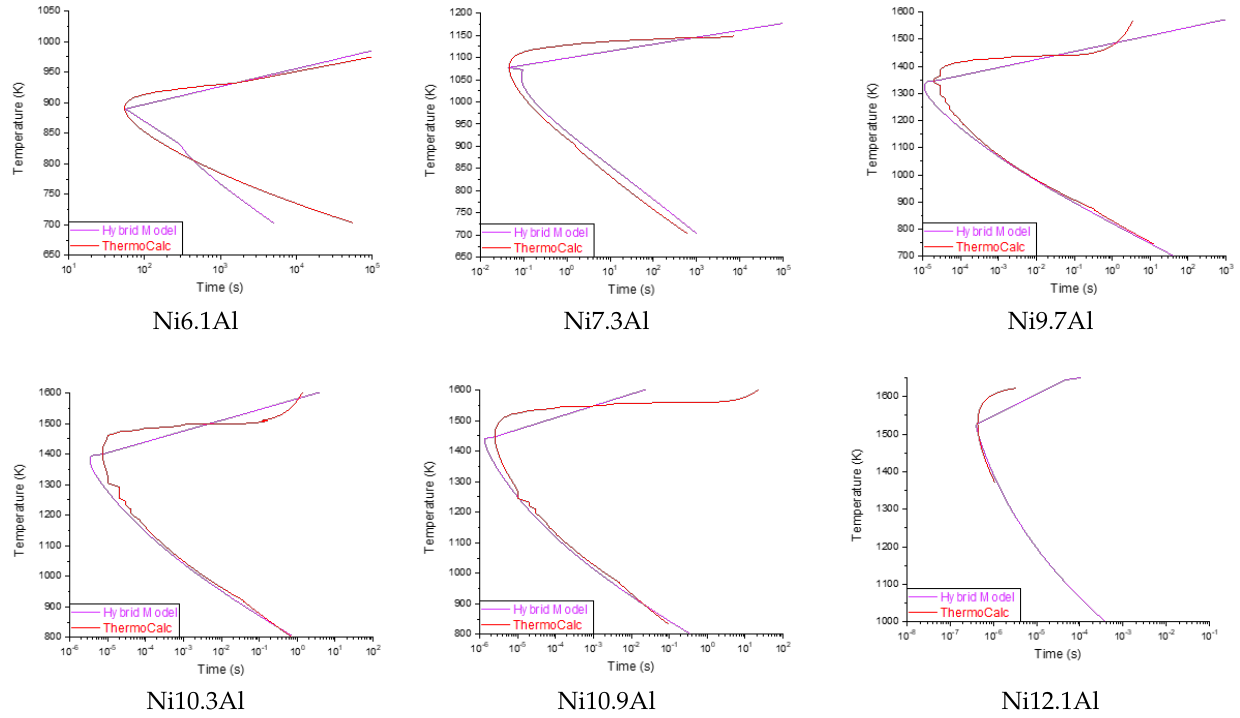
Figure 6. Prediction results for several chemical compositions of the proposed hybrid model against the Thermo-Calc™ . Table 7 shows the precision for each plot. As the chemical composition approaches the lower/upper limits, the accuracy